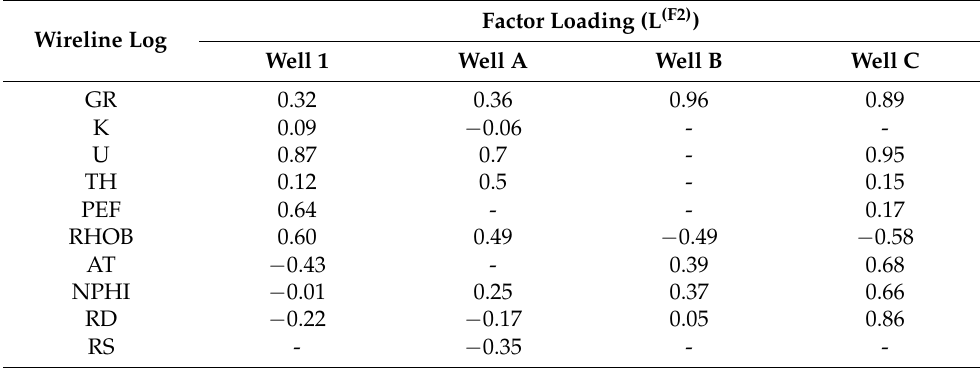
Table 6. Comparison of the loadings of the organic (second) factor for the analyzed unconventional hydrocarbon wells. Symbol (-) indicates no available logs. Factor Loading (L (F2) ) Wireline Log Well 1 Well